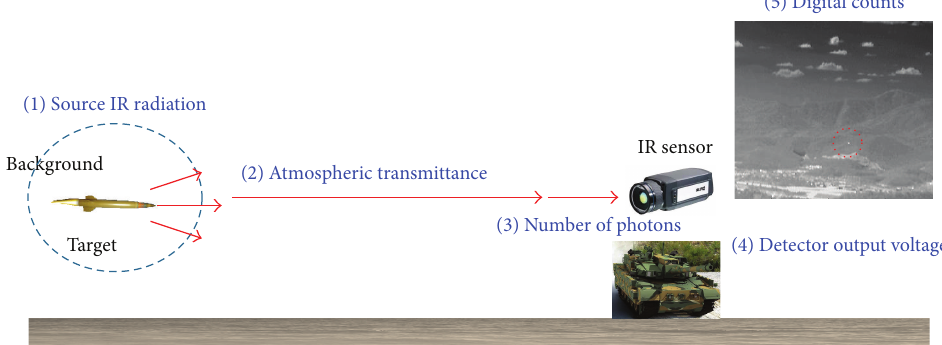
Figure 2: IR target imaging process and sources of IR